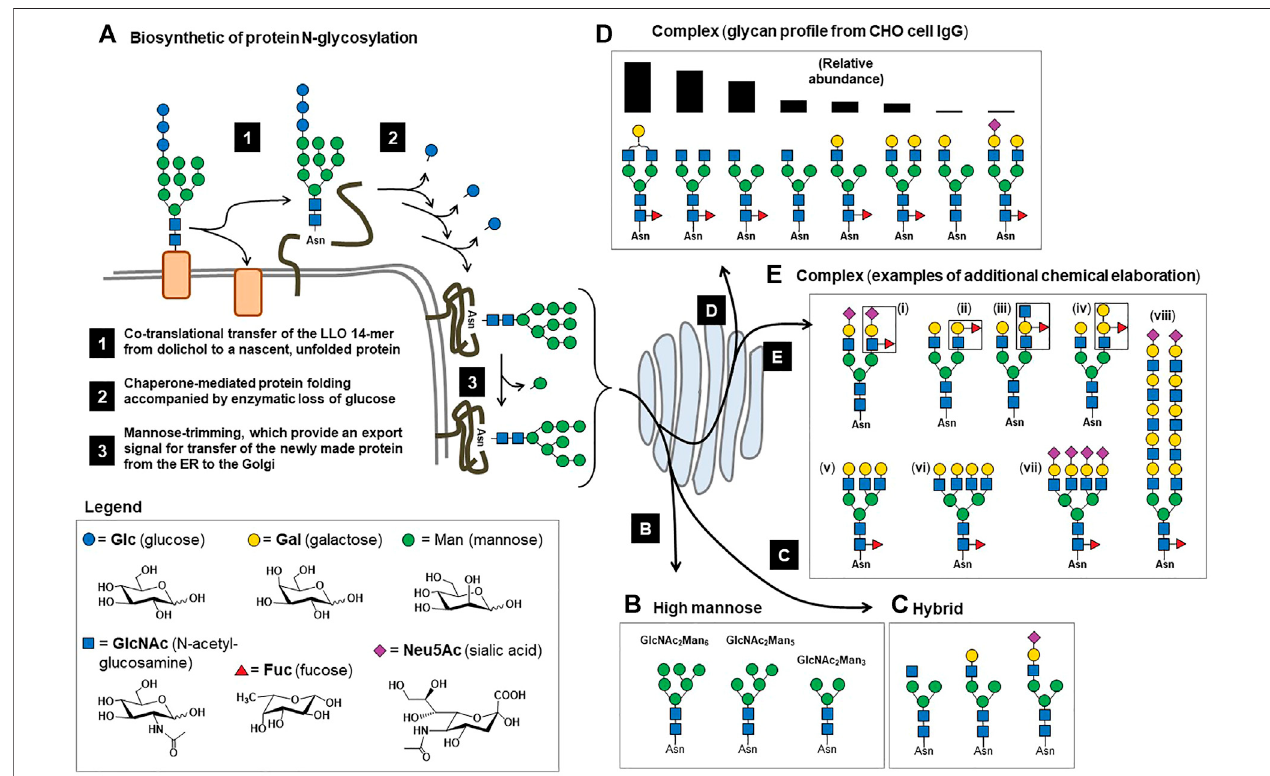
FIGURE 1 | Overview of mammalian N-glycosylation. (A) Step 1. The LLO 14-mer structure shown (GlcNAc 2 Man 9 Glc 3 ) is co-translationally transferred from dolichol phosphate to an asparagine residue of a nascent unfolded protein by oligosaccharyltransferase (OST) in the ER (Breitling & Aebi 2013). Step 2. Chaperone- mediatedproteinfoldingoccursconcomitantwithglucosetrimming,generatinga(inStep3)aGlcNAc 2 Man 9 orGlcNAc 2 Man 8 structurethatfunctionsasanexportsignal forthetransferofsuccessfullyfoldedproteinstotheGolgi(Helenius&Aebi2001). (B) IntheGolgi,furthertrimmingofmannoseresiduesoccurstoproduceaseries ofGlcNAc 2 Man n structuresreferredtoas “ highmannose ” -typeN-glycans,wherenistypicallybetween3and6. (C) AlsointheGolgi,one,two,orthreeGlcNAcresidues areaddedtoaGlcNAc 2 Man n structures,whichcanbefurtherelaborated(e.g.,withgalactoseandsialicacid,asshown)producing “ hybrid ” typeN-glycanswhenasingle GlcNAc is added to a GlcNAc 2 Man n structure. Hybrid N-glycans typically are low in abundance and have few known roles in therapeutic proteins. A larger proportion of N-glycans have GlcNAc residues added to both terminal mannose residues of the GlcNAc 2 Man 3 structure, most frequently resulting in small biantennary structures (Werz et al., 2007) such as those shown in Panel (D) , where the glycopro fi le of IgG Fc domain N-glycans from one study (del Val et al., 2016) are shown rank ordered by theirrelativeabundance. (E) Arelativelysmallproportion(generally5%orless)ofN-glycansarefurtherelaborated,resultinginepitopessuchas (i) sialylLewisx(sLe x ),the H,A,andBbloodtypeantigens [(ii),(iii) ,and (iv) ,respectively ] ; (v) tri-and (vi) tetra-antennarystructuresthatcanbeunsialylatedtofullysialylated (vii) ;and fi nallycertain N-glycanshave extended “ LacNAc ” repeats (four are shown) that can serve as preferred ligands for certain receptors, such as the hemagglutinin protein ofthe in fl uenza virus (Ji et al., 2017), whereas glycans from EPO can have single LacNAc repeats (Cowper et al., 2018).